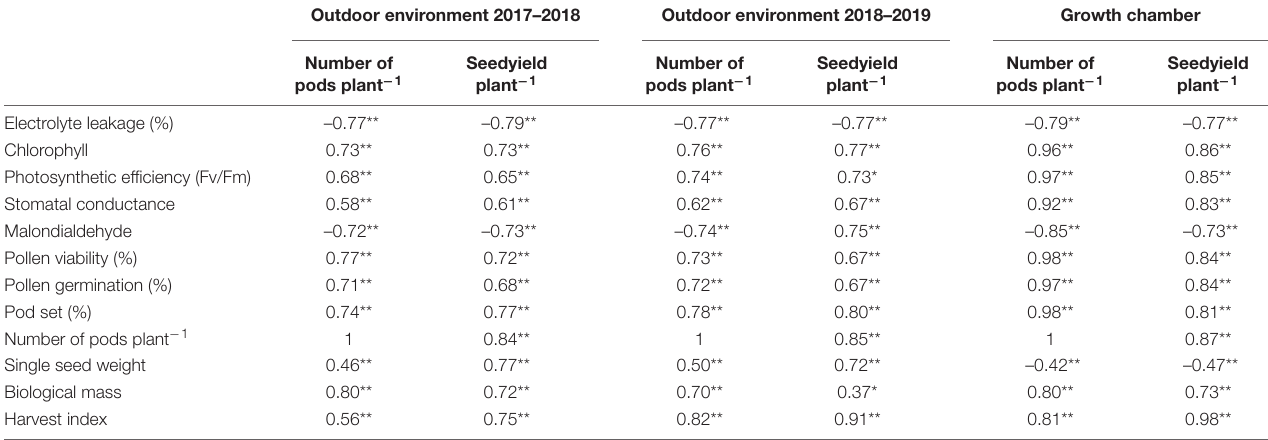
TABLE 3 | Correlation coefficients of various traits with yield traits in plants under heat stress